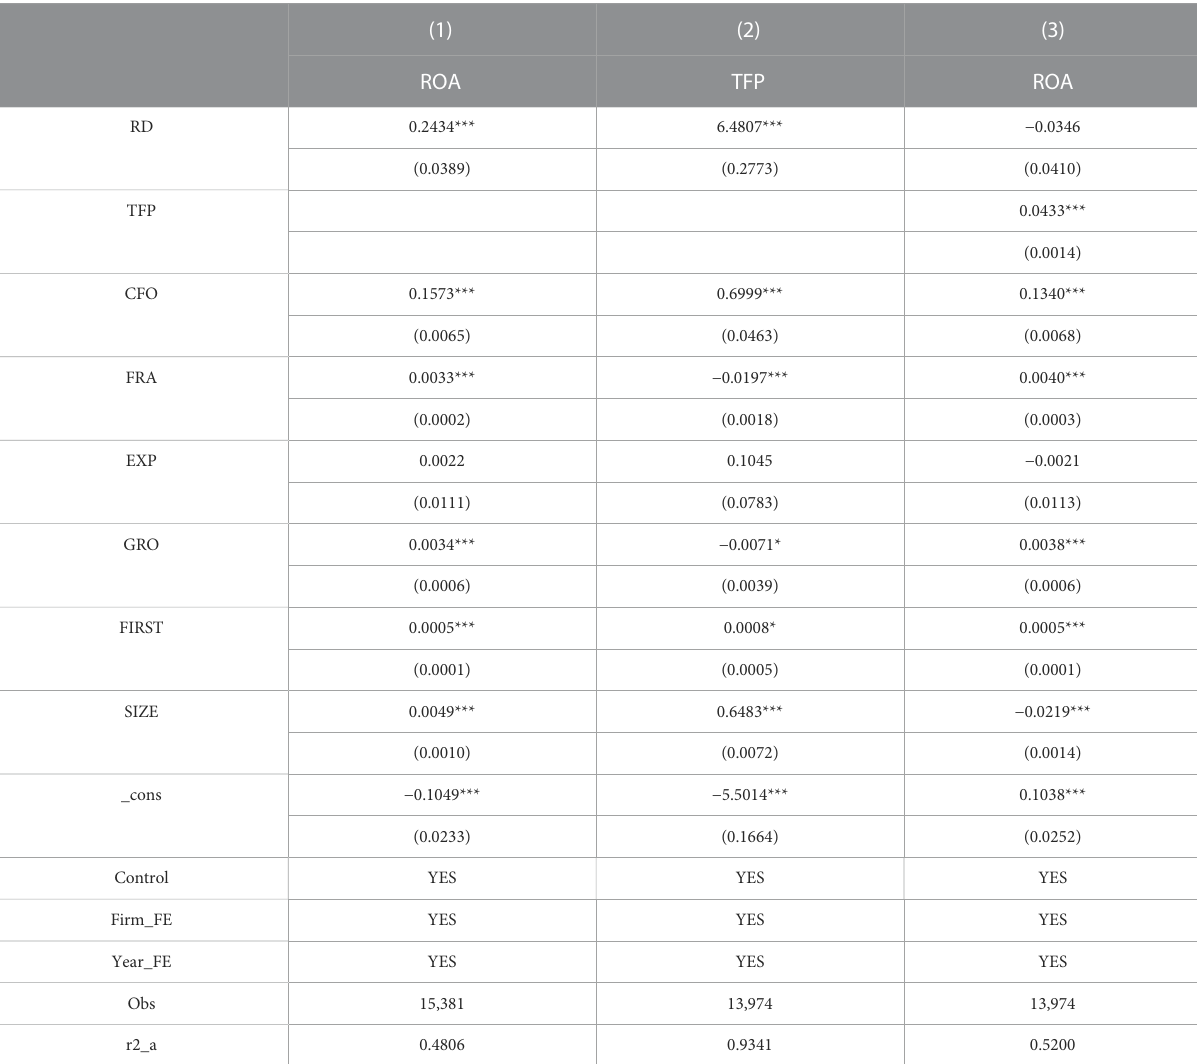
TABLE 6 Mediating effect